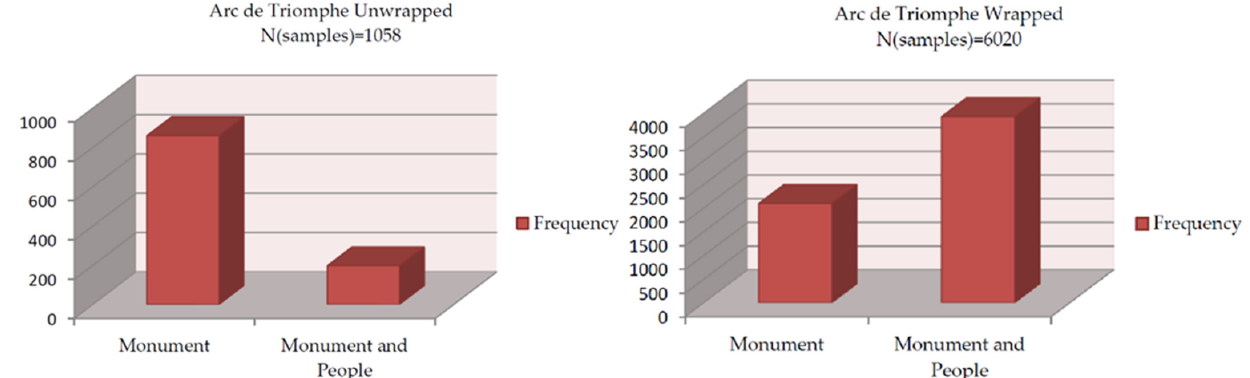
Figure 1. Graphic representation of the Instagram datasets. ( Left ) The frequency of classes in the Arc de Triomphe Unwrapped dataset. ( Right ): The graph indicates the frequency of photographs in the Arc de Triomphe Wrapped dataset.